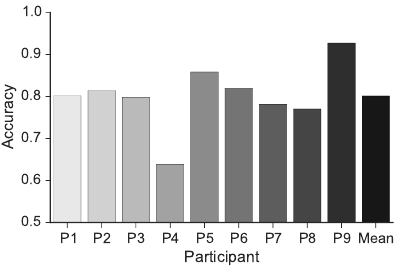
Figure 6: Screen-use detection: Normalised accu- racy per participant (cross-validation fold). Mean accuracy was 80 %. Results for participant 4 seems to be an outlier.